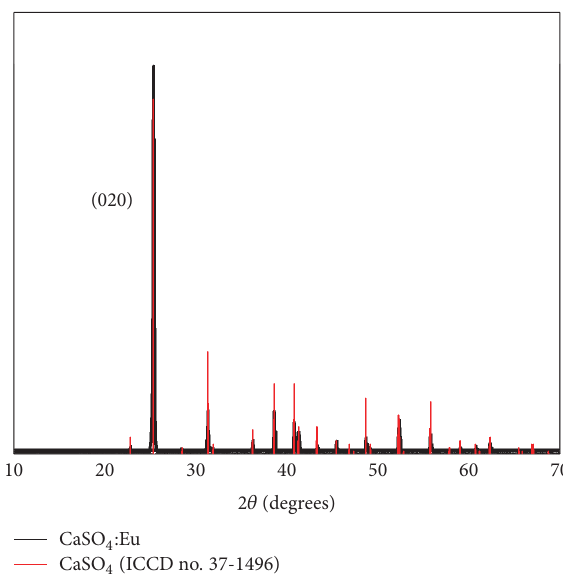
Figure 3: X-ray diffraction (XRD) pattern of synthesized CaSO 4 :Eu, together with the reference XRD peaks of CaSO 4 anhydrite (ICDD 37-1496).